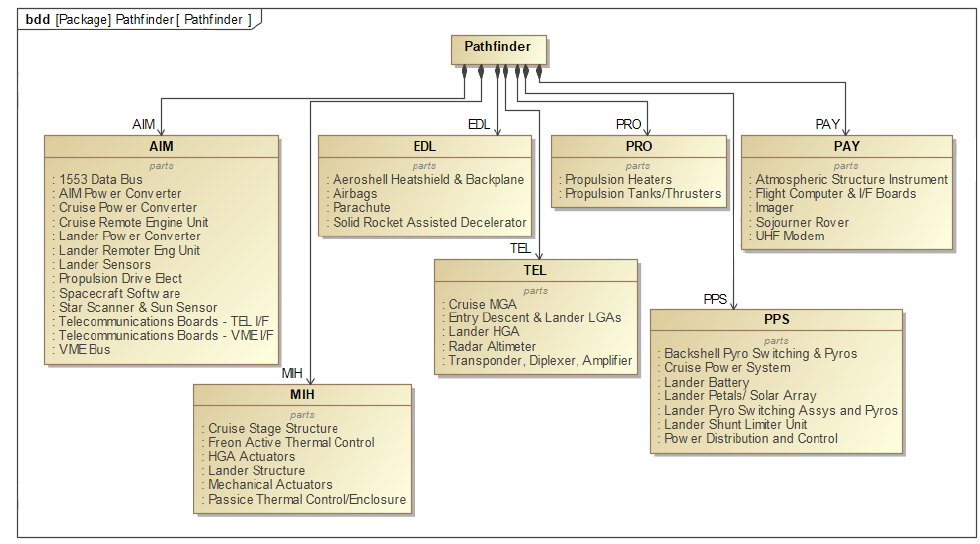
Figure 5. Pathfinder